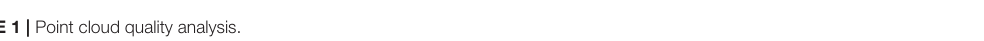
TABLE 1 | Point cloud quality analysis.